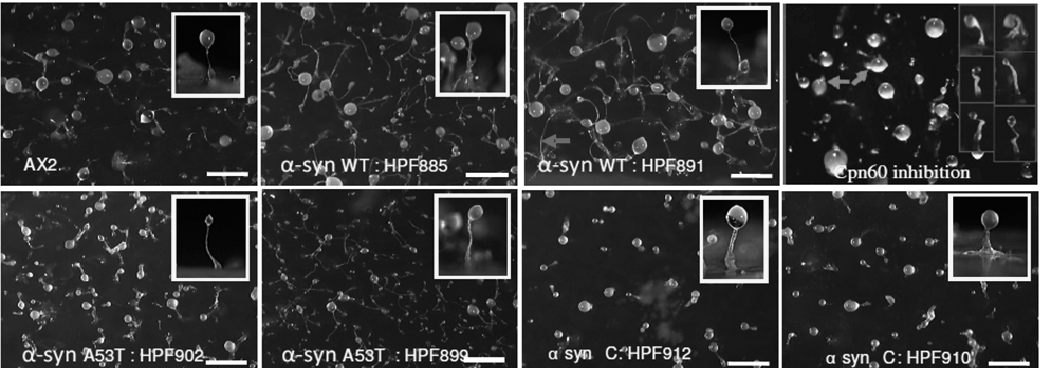
Figure 4. Multicellular morphogenesis of α -synuclein-expressing strains. Fruiting body morphology by the parental strain (AX2), strains expressing α -synuclein wild type ( α -syn WT), point mutant ( α -syn A53T), truncated ( α -syn ∆ C) α -synuclein and mitochondrial disease strain (Cpn60 inhibition). The α -syn WT and α -syn A53T produce thinner, longer stalks while the α -syn ∆ C display fewer fruiting bodies with shorter and thicker stalks. Insets show the side view of a single fruiting body. The scale bar shows 1 mm.